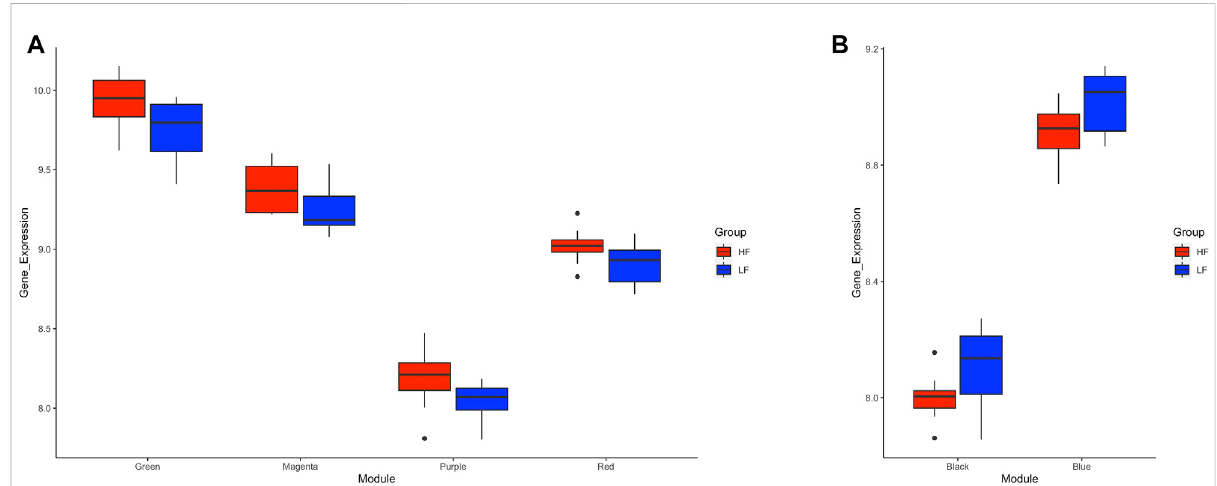
FIGURE 6 Box plots of average transformed expression for genes in modules correlated with high fertility (HF) or low fertility (LF) groups. Genes in each moduleareco-expressed,accordingtoweightedgeneco-expressionnetworkanalysis(WGCNA).Modulescorrelated( p < 0.05)with (A) HFgroupor